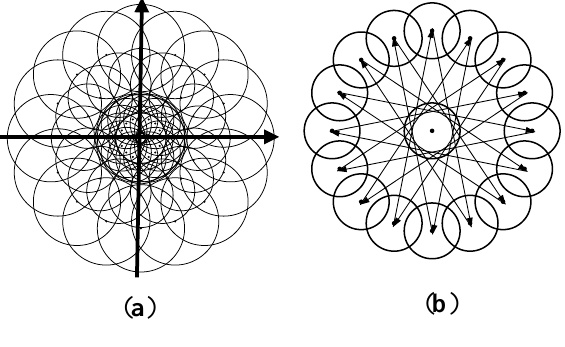
Figure 3. ( a ) Sample pattern containing three layers, where each layer has 17 sample grids with polar arrangement; ( b ) Pairs used for main orientation estimation based on the outermost